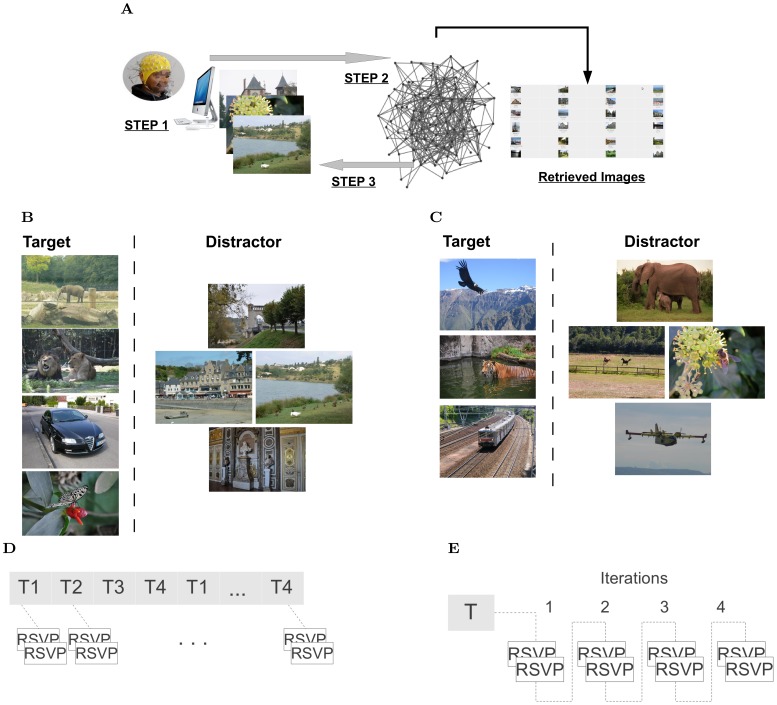
EEG-based image retrieval.(A) The framework: step 1 - The RSVP sequence of images, presented to the subject, is labeled based on the recorded EEG signals. step 2 - These labels are propagated to the unseen images in the database using CV similarity. step 3 - A new RSVP sequence is built from the images top-ranked as target, in accordance to the label propagation results. These steps are repeated iteratively allowing the accumulation of multimodal labels for the images in the database. (B) Illustration of the training images (four different search tasks). (C) Illustration of the testing images (three different search tasks). The images in the figure are similar but not identical to the ones used in the study. Reprinted from http://www.freephotobank.org/main.php and http://animalphotos.info/a/(26-4-2013) under a CC-BY or CC-BY-SA license. Image Copyright is held by original owners. (D–E) The organization of the RSVP sequences in the training and testing phases respectively (T – a search task).